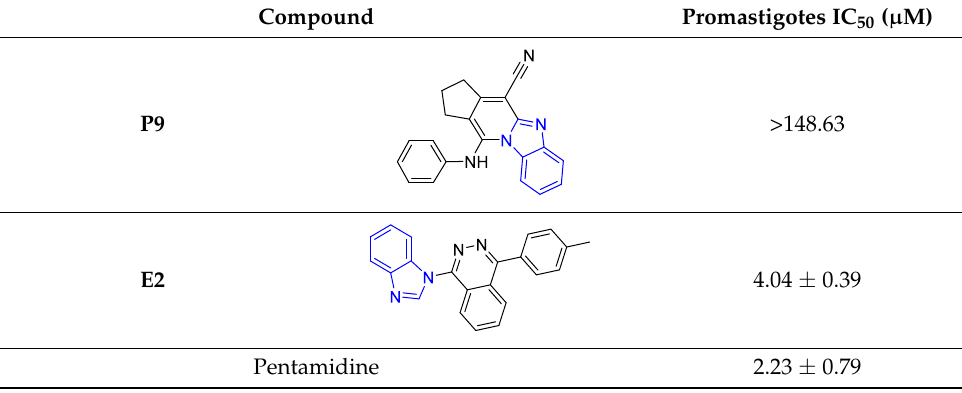
Table 4. Leishmanicidal activity of benzimidazole derivatives against L. mexicana promastigotes.